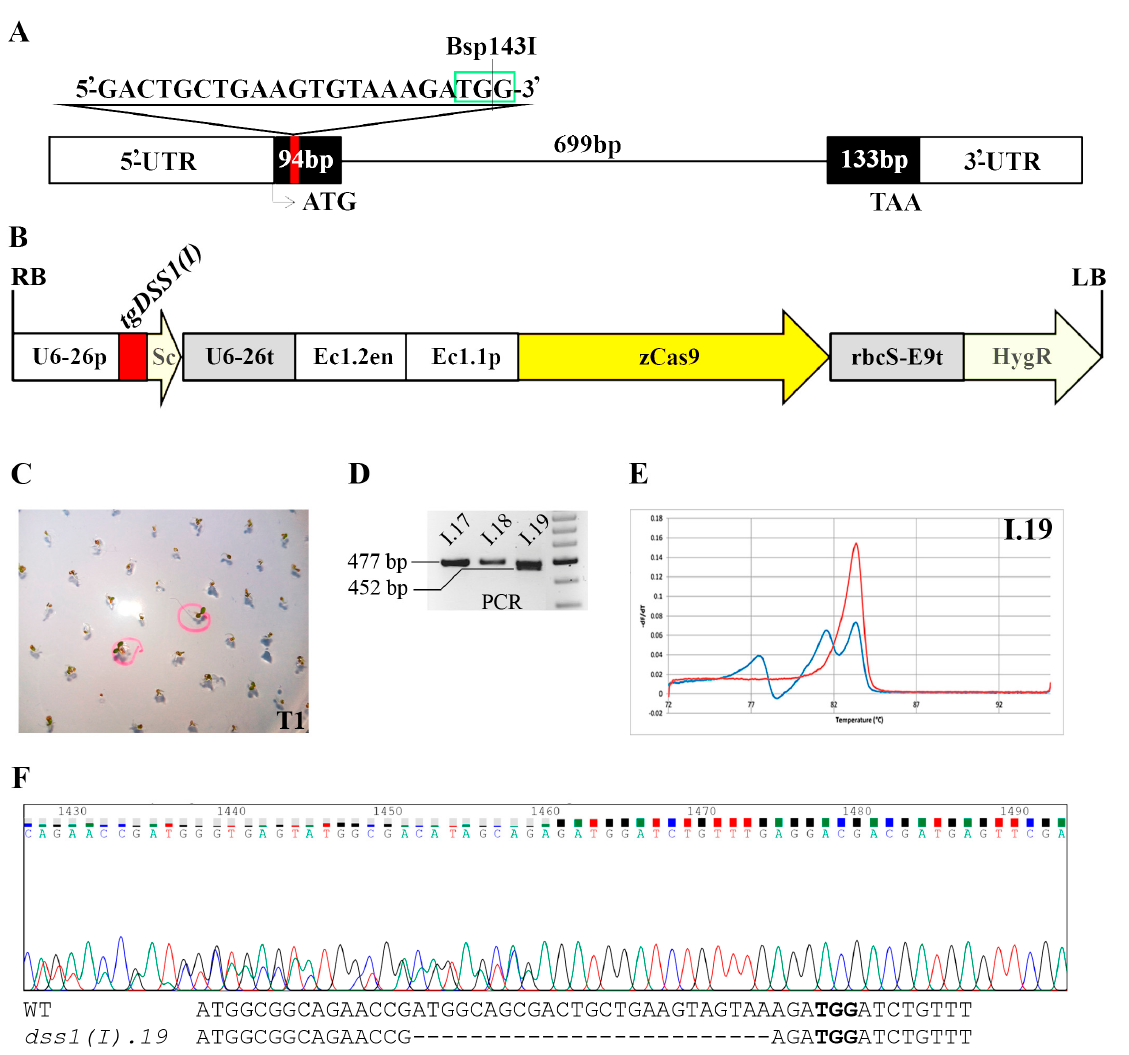
Figure 2. Construction strategy for AtDSS1(I) gene editing by CRISPR/Cas9 via Agrobacterium -mediated transformation of Arabidopsis and mutant screening approaches. ( A ) Schematic diagram of the AtDSS1(I) gene indicating the sgRNA target site ( tgDSS1(I) ) (red line), its sequence with PAM (green square), and Bsp143I restriction site; 5’ and 3’ UTRs are shown as white boxes; exons are shown as black boxes; the line indicates intron position; ATG is start codon and TAA is stop codon. ( B ) Structure of the CRISPR/Cas9 binary vectors pHEE401E for Arabidopsis transformation: tgDSS1(I) was controlled by the U6-26p–U6 promoter for PolIII; Sc-scaffold; the Cas9 cassette was driven by the EC1.2en and EC1.1p—egg-specific enhancer-promoter combination for zCas9 ( Zea mays codon-optimized Cas9) expression in egg and zygote; rbcS-E9t—terminator of zCas9; Hyg— hygromycin-resistance gene; RB/LB are T-DNA right/left borders. ( C ) The photo of the selection of hygromycin-resistant Arabidopsis seedlings in the T1 generation. ( D ) The electropherogram of DNA fragments amplified by the primers designed to encompass the potential indel site (plant I.19 with large deletion ( del ); I.17, I.18—examples of plants with same PCR fragment length as WT plant). ( E ) HRM analysis of dss1(I).19 genotype. ( F ) Sanger sequencing chromatogram of the generated heterozygous Atdss1(I).19 plants in T2 generation, followed by the alignment of WT and mutant sequence. Bold letters represent PAM sequence.